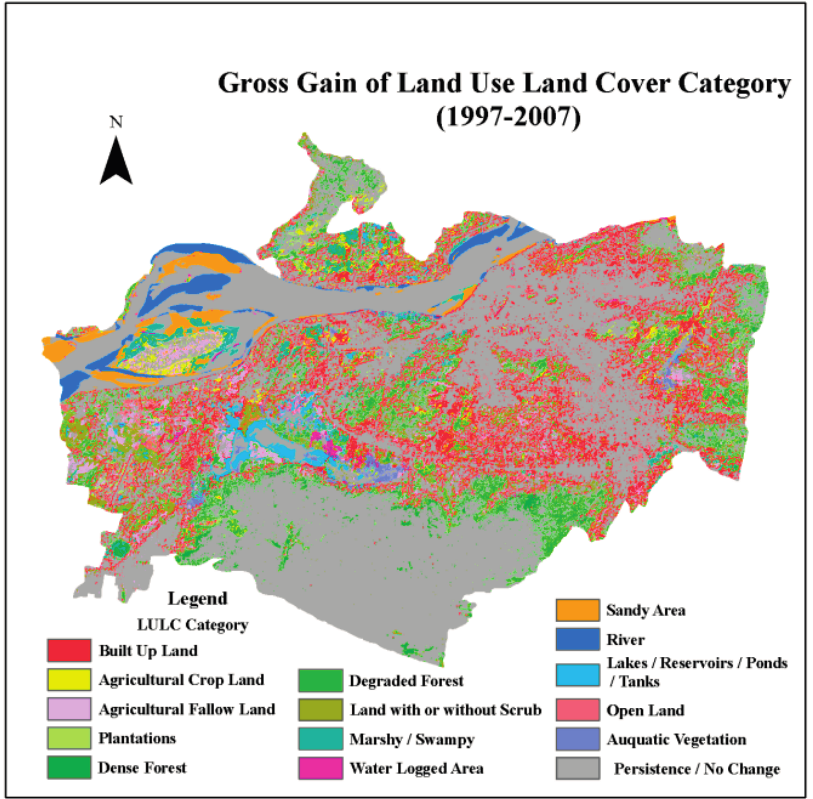
Figure 14. Gross gain of each LULC category during 1997 and